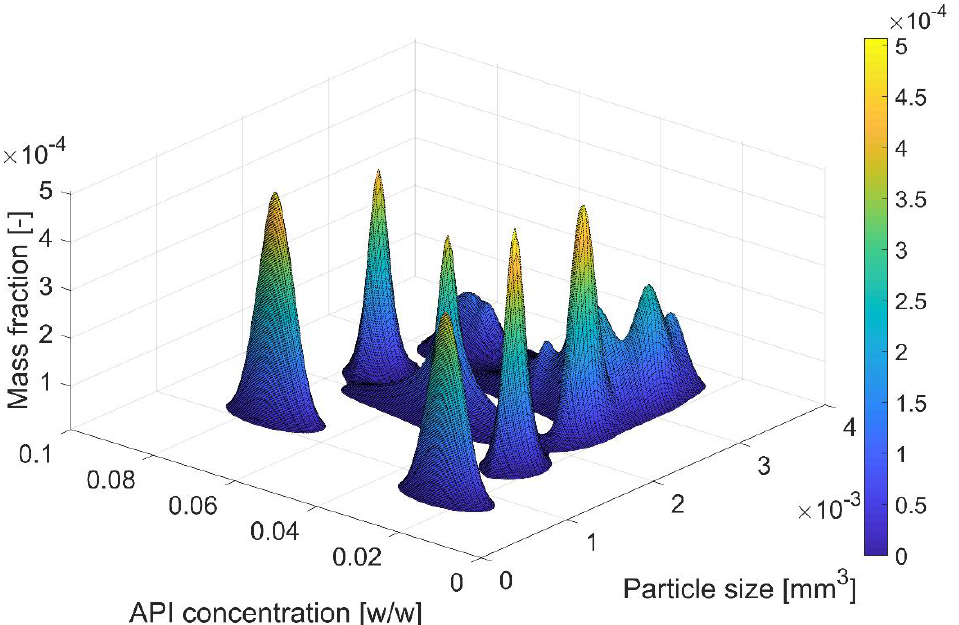
Figure 6. Simulation results of the agglomeration process.